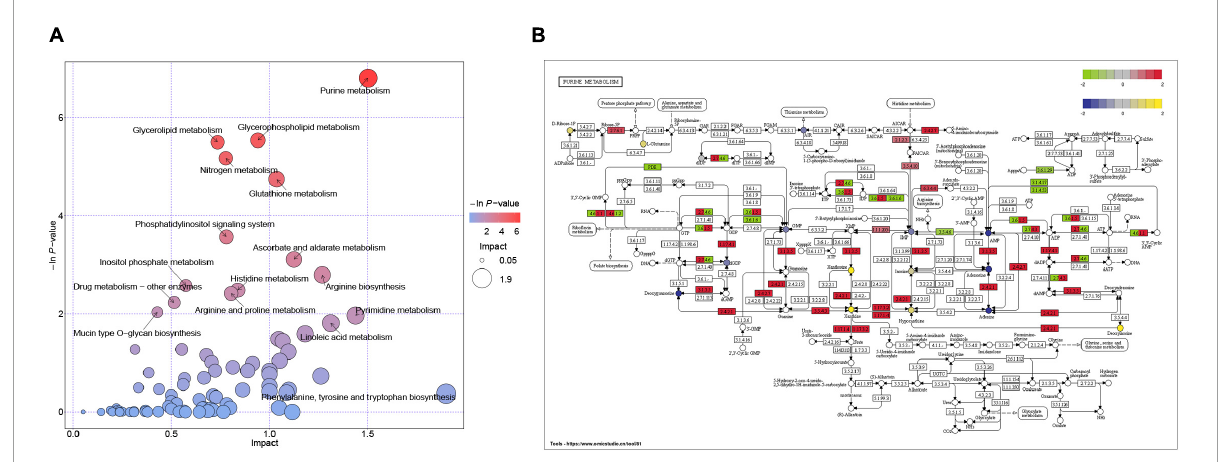
FIGURE5 Integration analysis of transcriptomics and metabolomics. (A) Pathways enriched with both genes and metabolites. Each bubble in the bubble diagram represents a pathway, the horizontal axis where the bubble is located and the bubble size indicate the size of the influence factor of that pathway in the analysis, and the vertical axis where the bubble is located and the bubble color indicate the P -value of the enrichment analysis (taking the negative natural logarithm, namely − ln(p)). (B) The molecular mechanisms of dysregulation of purine metabolism at the gene and metabolite levels. Circles represent metabolites and colored ones represent differential metabolites, and rectangles represent genes and colored ones represent differential genes.